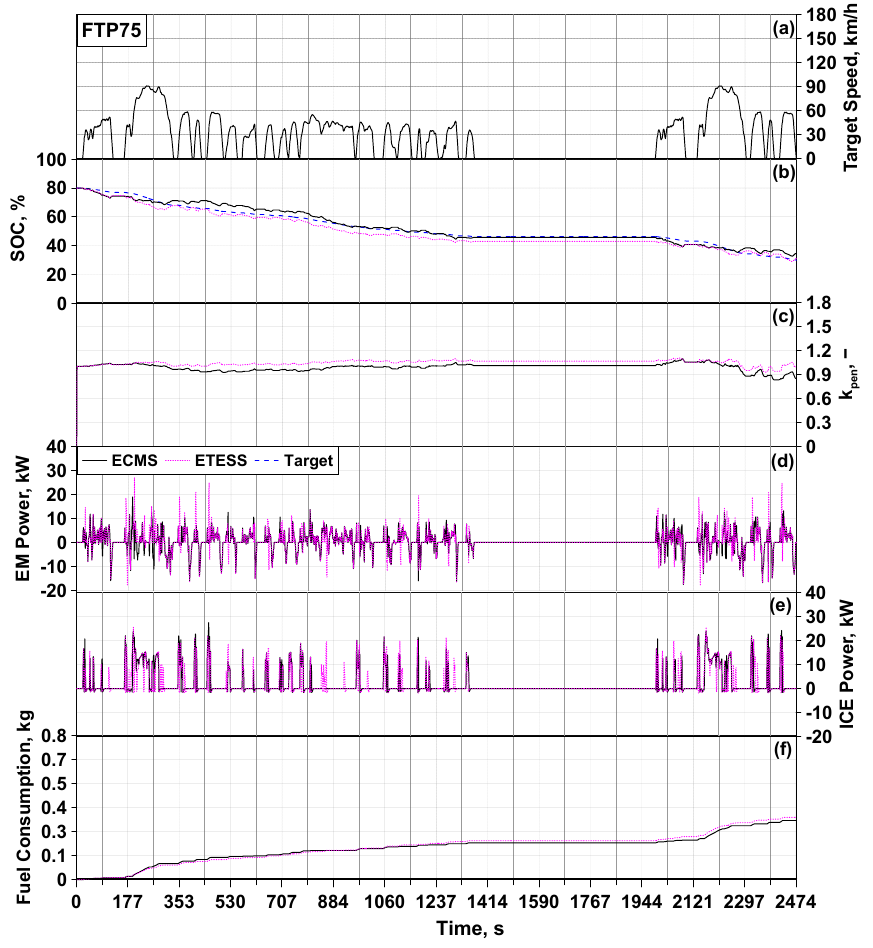
Figure 14. FTP75, ( a ) target speed. ETESS/ECMS comparisons of battery SoC ( b ), k pen ( c ), EM power ( d ), ICE power ( e ), and cumulated consumed fuel ( f ).